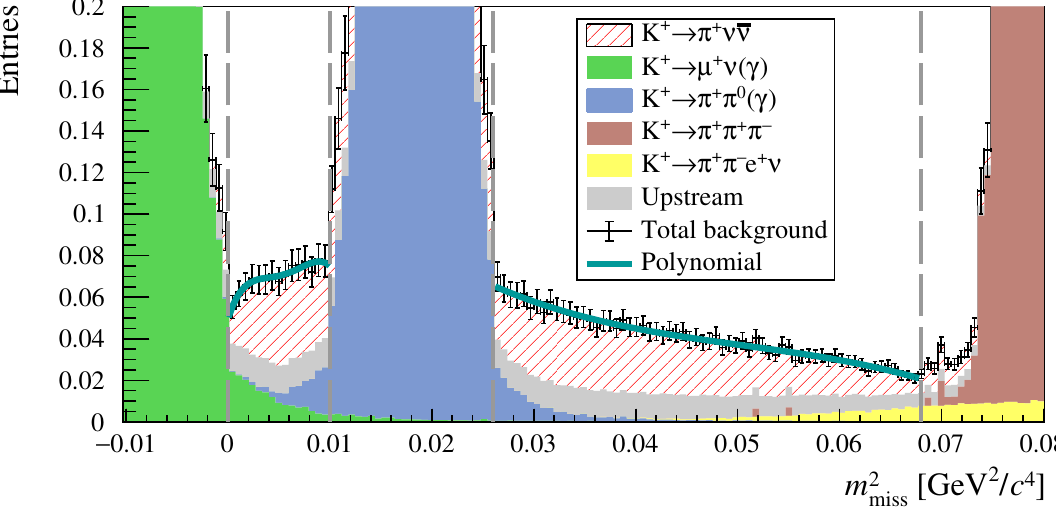
Figure 3 . Distributions of the expected reconstructed squared missing mass, m 2 processes, obtained from simulations and data-driven procedures, displayed as stacked histograms with bin width 0 . 00067 GeV 2 /c 4 . In each signal region, the polynomial function used to describe the total background is